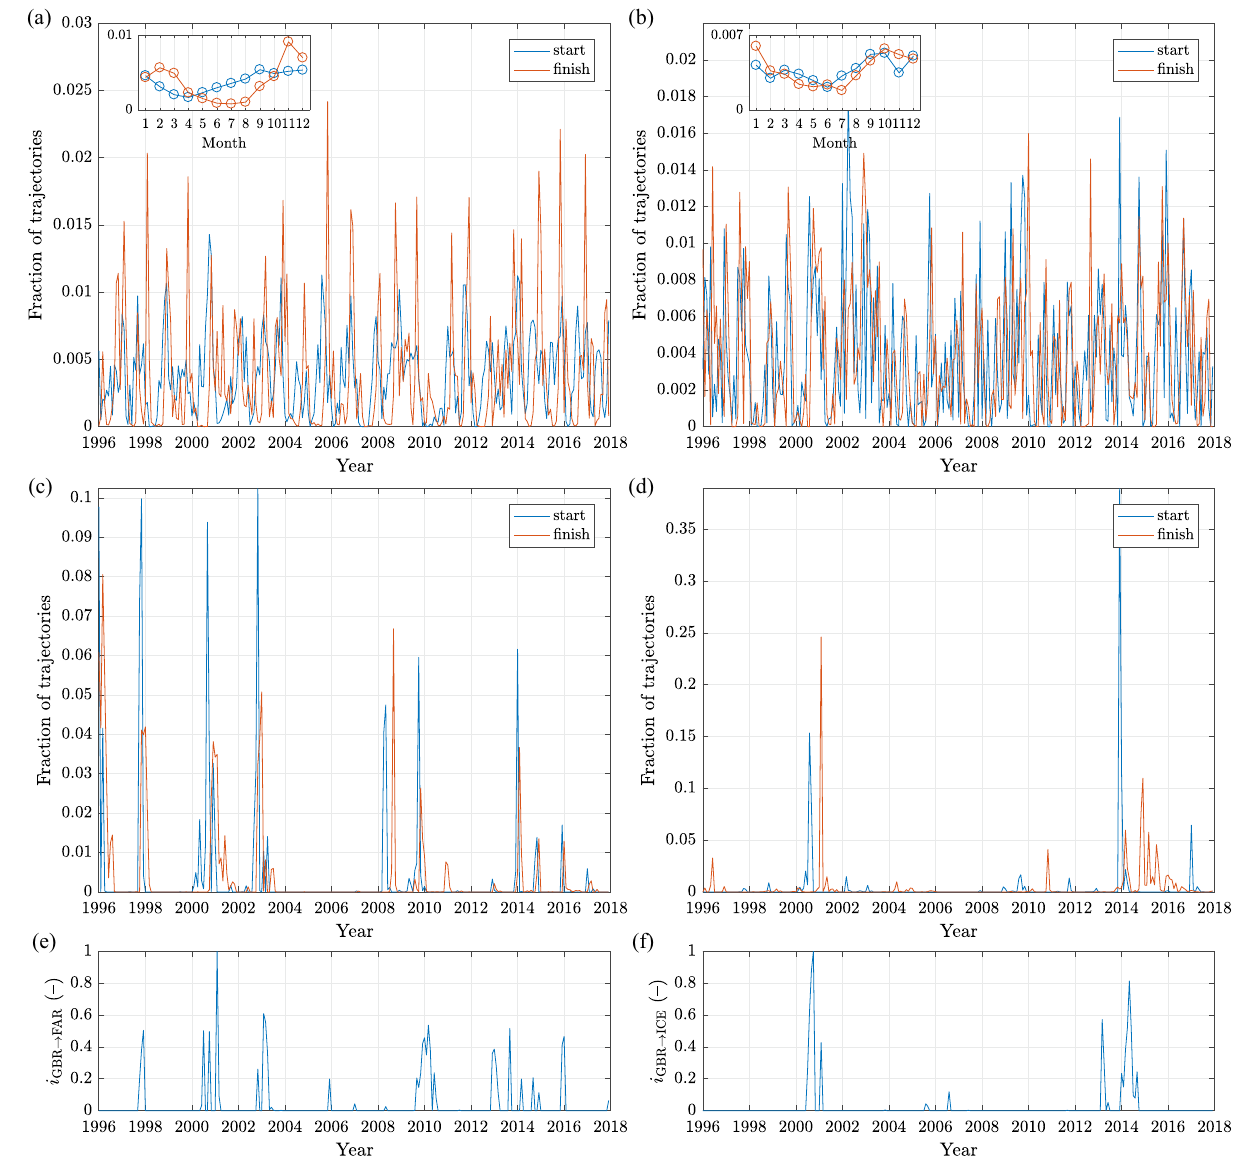
Figure 5. ( a – d ): Time series of total monthly release (blue) and landing (red) events from GBR to NOR ( a ), SHE ( b ), FAR ( c ) and ICE ( d ). ( e , f ): Time series (normalized with maximum values) of the atmospheric indices i GBR t ) and i GBR t ) defined in Eqs. (1)–(3). In all plots the period 1996–2017 is shown, for which → FAR ( → ICE (